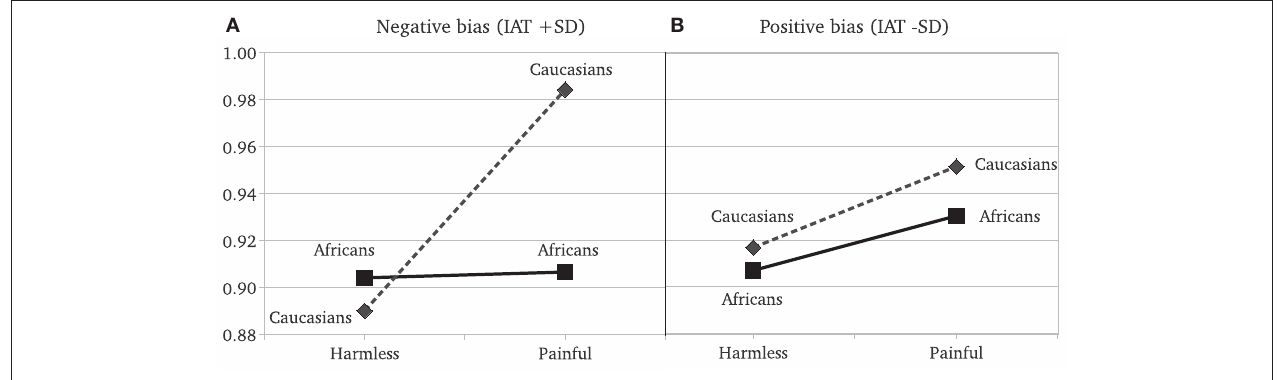
Figure 3 | experiment 2: simple slope analysis. Estimated SCR means as a function of stimulus type and the race of the person computed at two different levels of IAT scores: (A) estimation for strong negative bias for Blacks (1 SD above average IAT score); (B) estimation for positive bias for Blacks (1 SD below average IAT